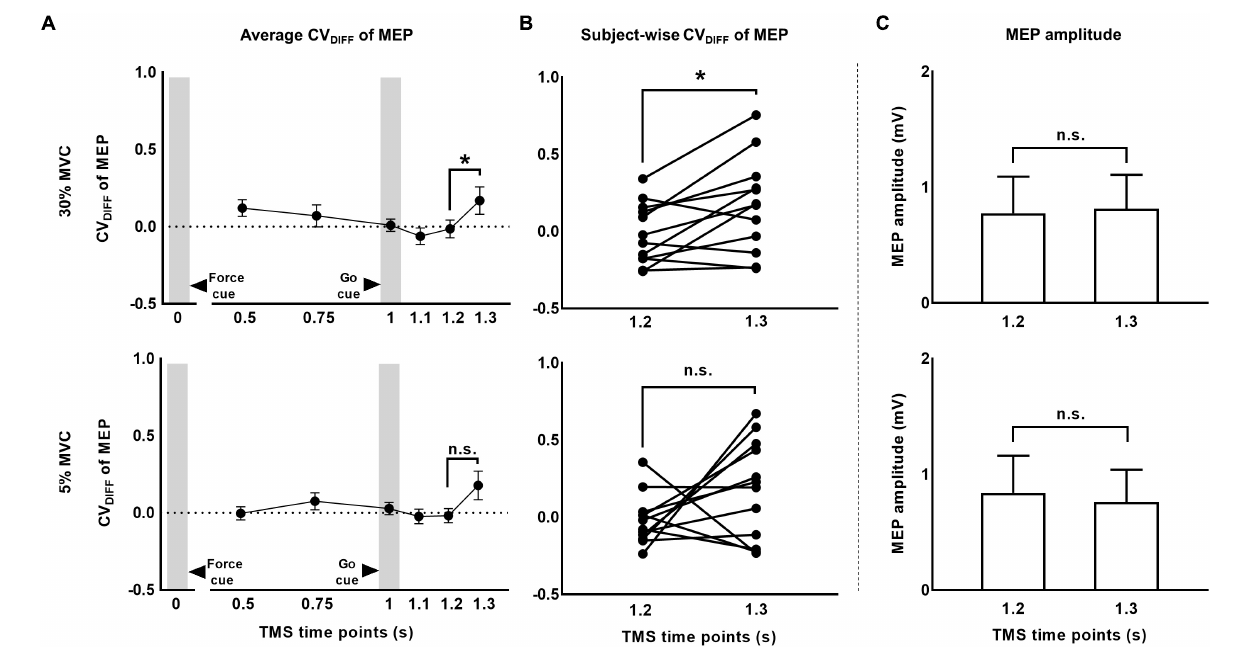
FIGURE 6 | The CV of MEP rose above and beyond changes in MEP amplitude. (A) Time-course of CV DIFF (observed – predicted CV) of MEP at 30% and 5% of force. (B) Subject-wise CV of MEP data indicates a consistent rise across subjects from 1.2 to 1.3 s at 30%, but not at 5% of force. (C) MEP amplitude analysis showed no modulation from 1.2 to 1.3 s. Data in (A,C) are averages of all subjects (vertical bars denote SE). Asterisks indicate p < 0.016 and n.s. indicates p > 0.1.